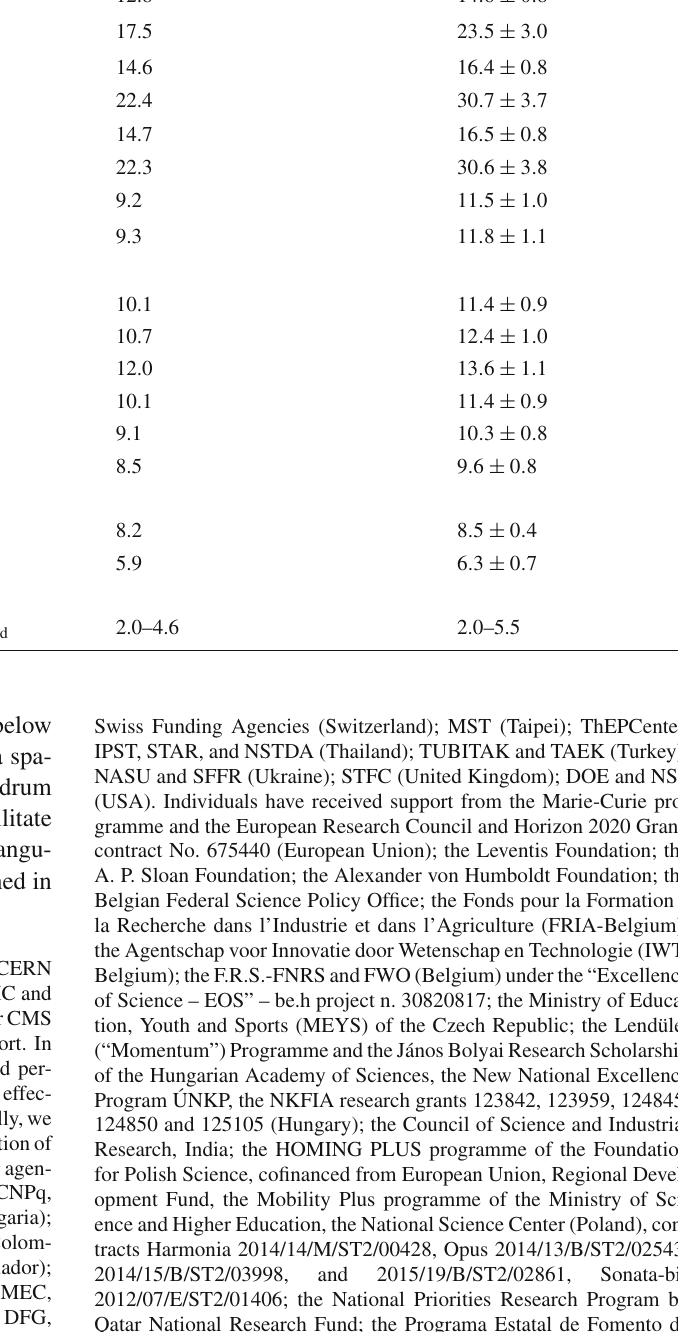
Table 2 Observed and expected exclusion limits at 95% CL for various CI, ADD, QBH, and DM models. The 68% ranges of expectation for the expected limit are given as well. For the DM vector mediator, couplings g DM = 1 . 0, g q ≥ 1 and a DM mass of 1GeV are assumed and a range of masses instead of a lower limit is quoted